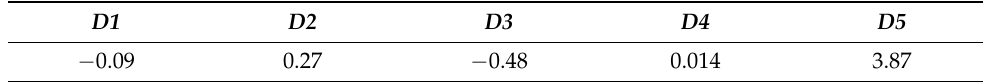
Table 3. J-C damage model